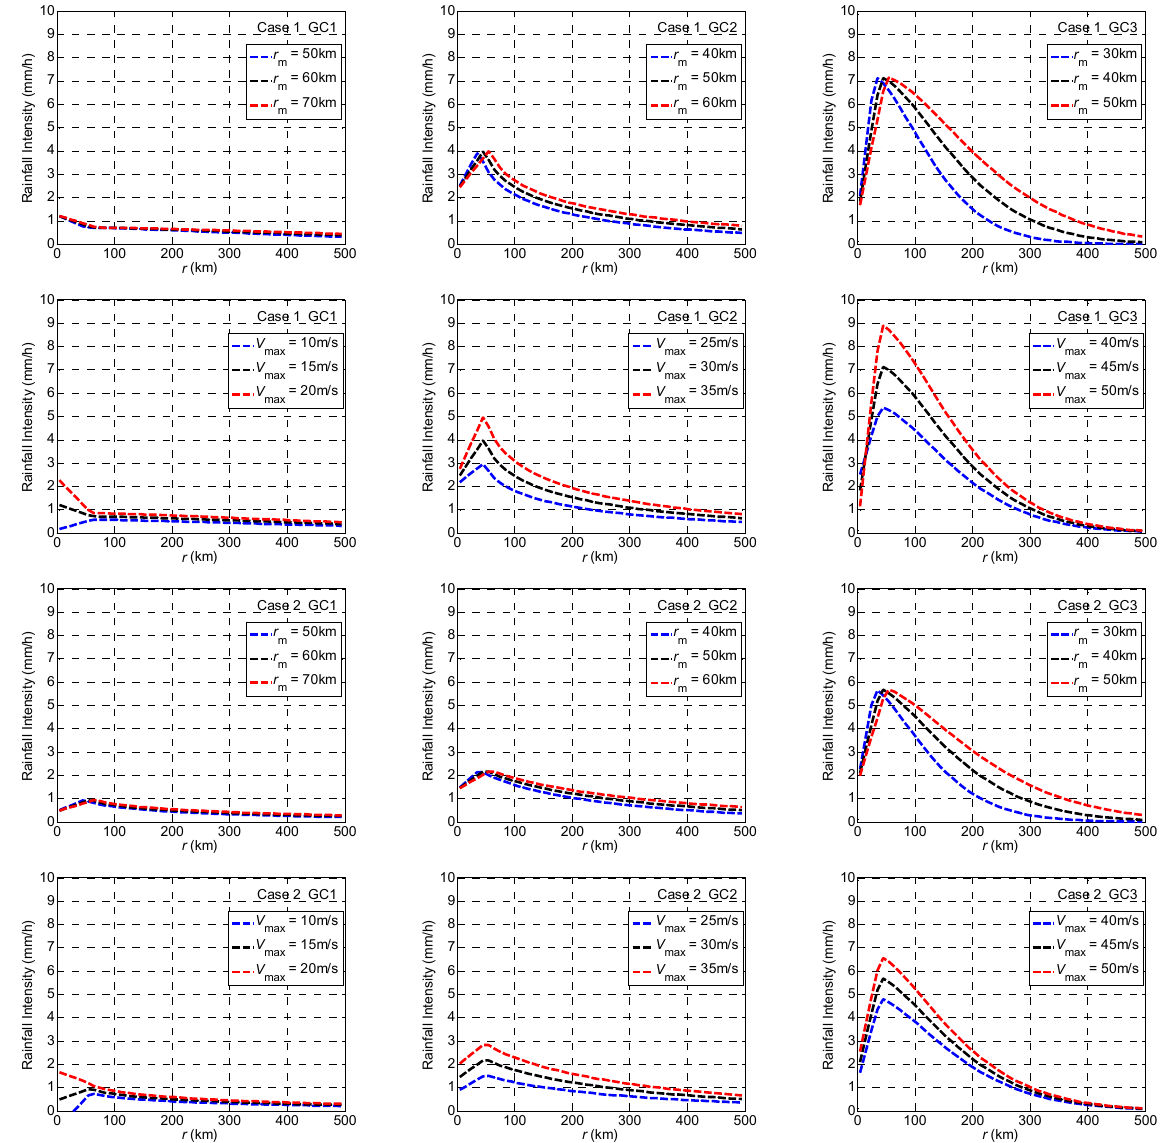
Figure 3. Predicted azimuthally averaged rainfall intensity using the model parameters shown in Table 2. For the plots where V max is shown, r m equals 60, 50, and 40 km for GC1, GC2, and GC3, respectively. For the plots where r m is shown, R max equals 15, 30, and 45 m/s for GC1, GC2, and GC3, respectively.